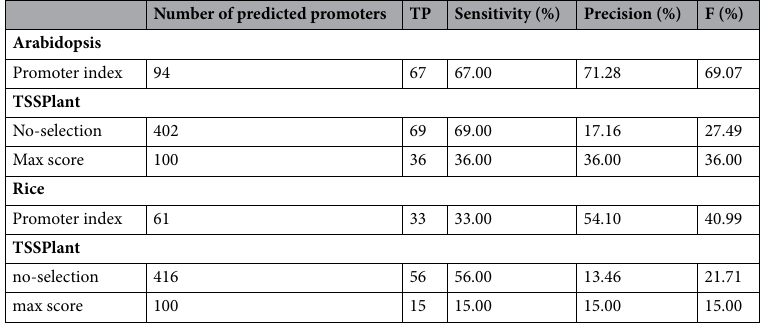
Table 1. Comparison with TSSPlant. Two kilobase sequences from CDS of 100 randomly selected genes of Arabidopsis and rice were subjected to our prediction (Promoter Index) and TSSPlant. TP true positive, F harmonic mean of sensitivity and precision. Success of the prediction by TSSPlant indicates the presence of a Genic Top TSS within 100 from the predicted TSS